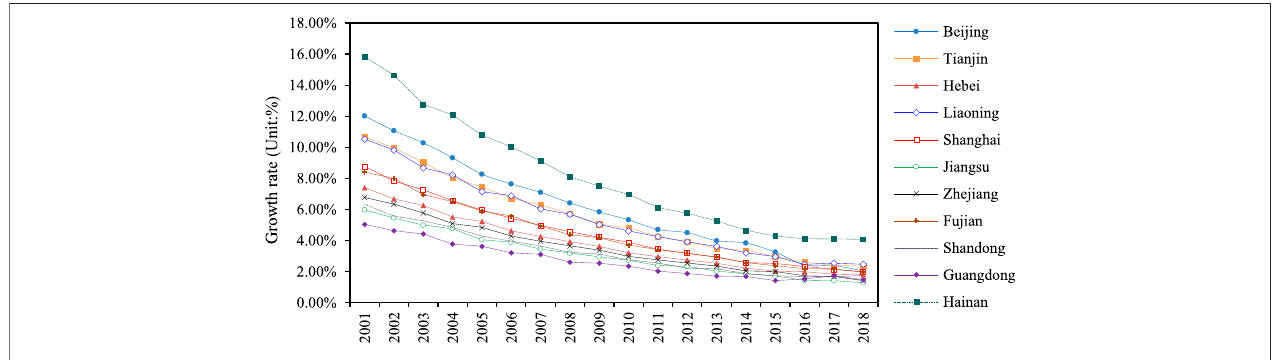
FIGURE 1 | Changes in the annual growth rate of TCP in eastern China.